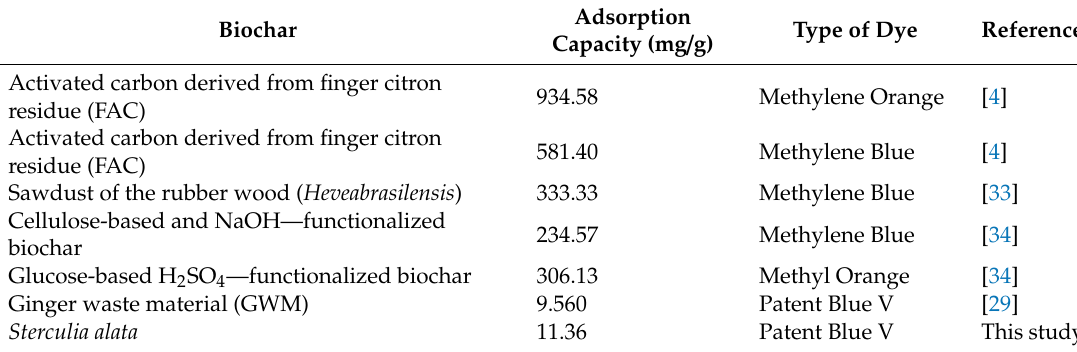
Table 3. Comparison of the adsorption capacities for di ff erent dyes using various types of biochar. Adsorption Type of Dye Biochar Capacity (mg / g) Activated carbon derived from finger citron 934.58 Methylene Orange [4] residue (FAC) Activated carbon derived from finger citron 581.40 Methylene Blue [4] residue (FAC) Sawdust of the rubber wood ( Heveabrasilensis ) 333.33 Methylene Blue [33] Cellulose-based and NaOH—functionalized 234.57 Methylene Blue [34] biochar Glucose-based H 2 SO 4 —functionalized biochar 306.13 Methyl Orange [34] Ginger waste material (GWM) 9.560 Patent Blue V [29] Sterculia alata 11.36 Patent Blue V This